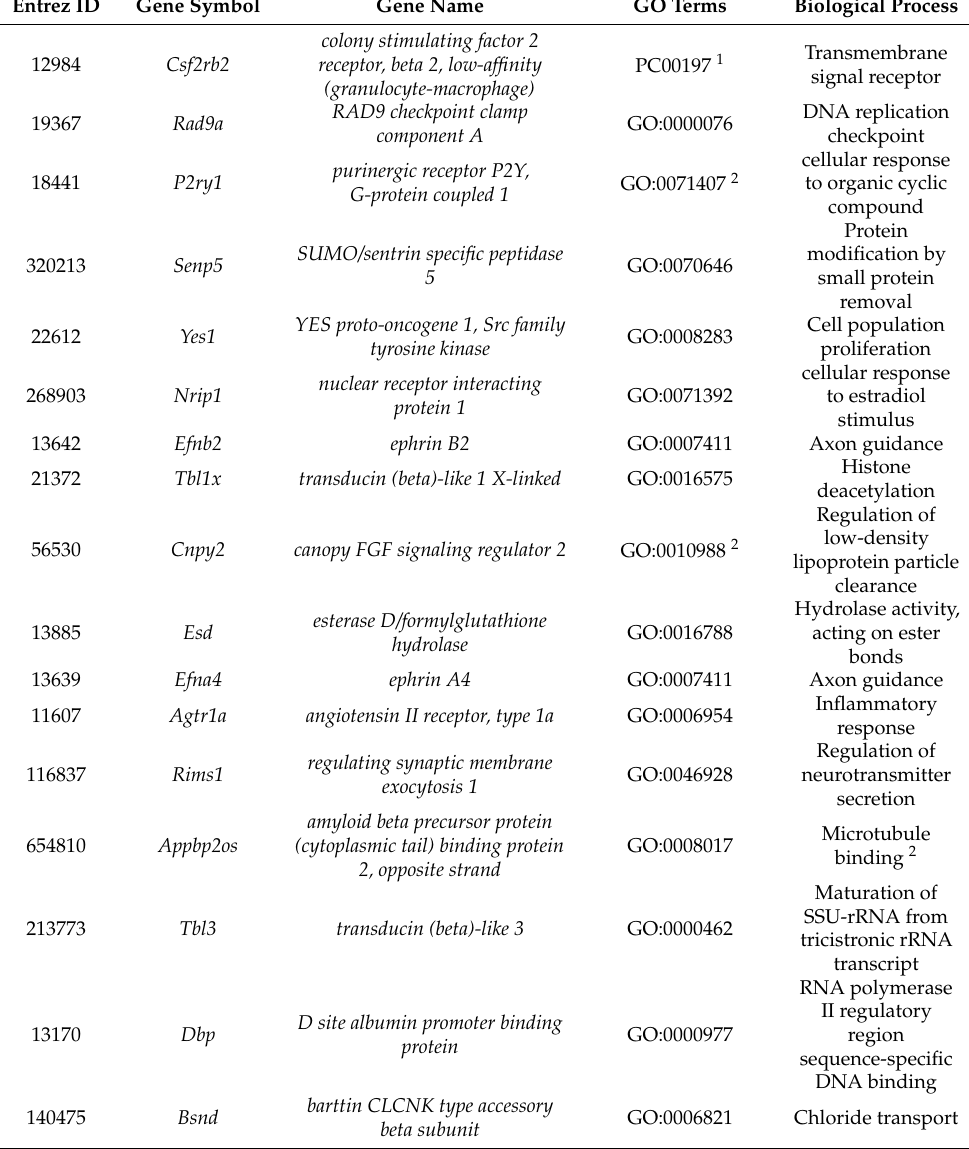
Table 7. Genes common among all important features from three datasets: simple scaled dataset, dataset without correlated genes and dataset without co-expressed